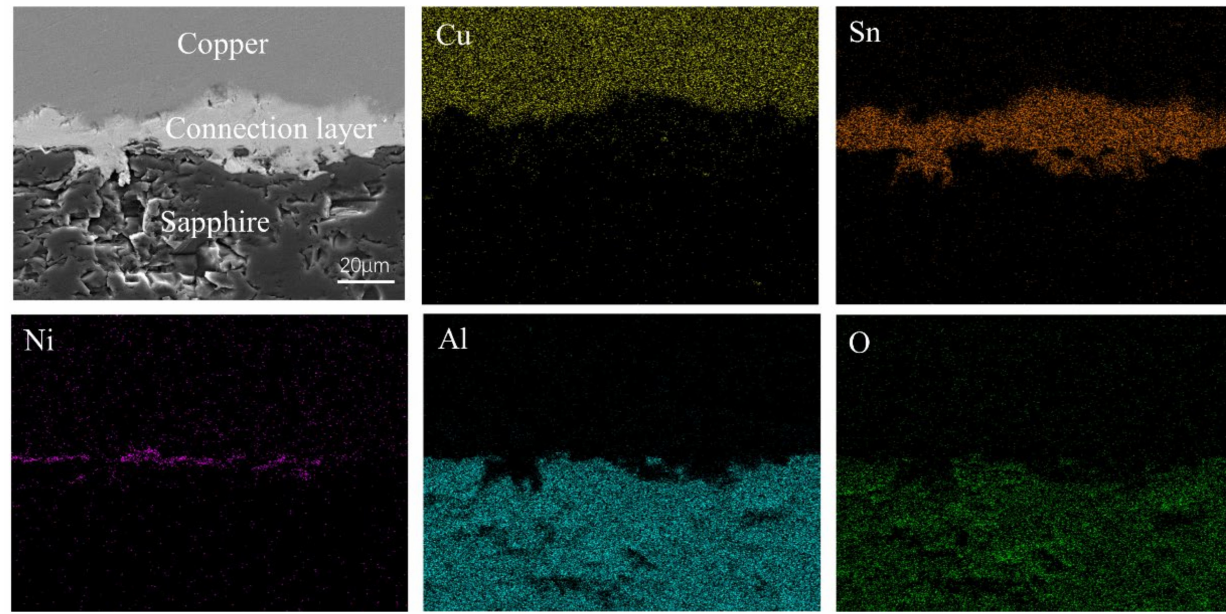
Figure 7. Morphology and EDS elemental distribution at Cu/sapphire solder